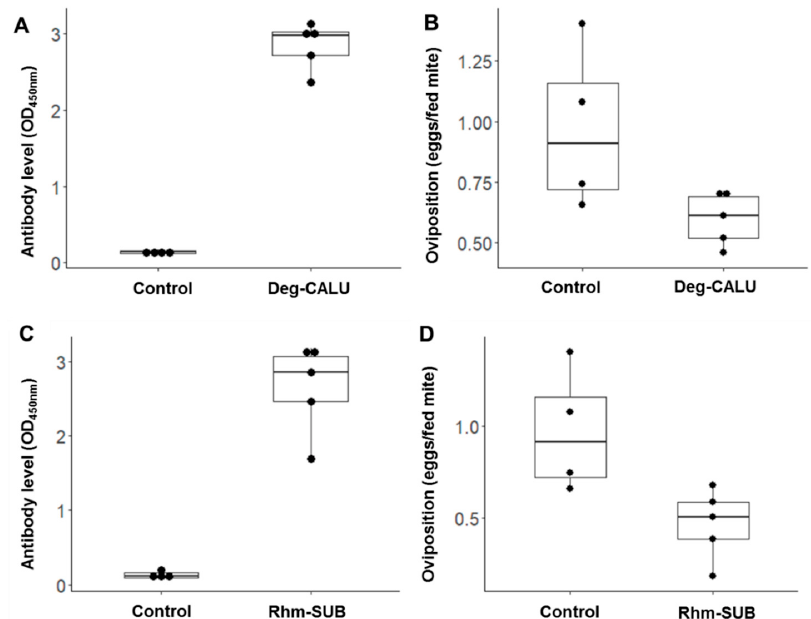
Figure 8. Comparison of antibody level and oviposition amongst groups. Antibody levels at the moment of infestation were determined by ELISA in vaccinated and control hens against Deg-CALU ( A ) and Rhm-SUB ( C ). Antibody titers are determined as the average OD450nm of three replicates and compared between vaccinated and control groups by Mann-Whitney U test (* p < 0.05). Oviposition of the Deg-CALU group ( B ) and Rhm-SUB ( D ) are shown to be compared with the control group. Oviposition is calculated as eggs laid / number fed adult viable female mites counted at day 7 of monitorization. Effect in oviposition is statistically significant in both groups (GLMM, p < 0.01). Vaccination did not affect mite feeding rates, mortality, egg hatchability and larval development.